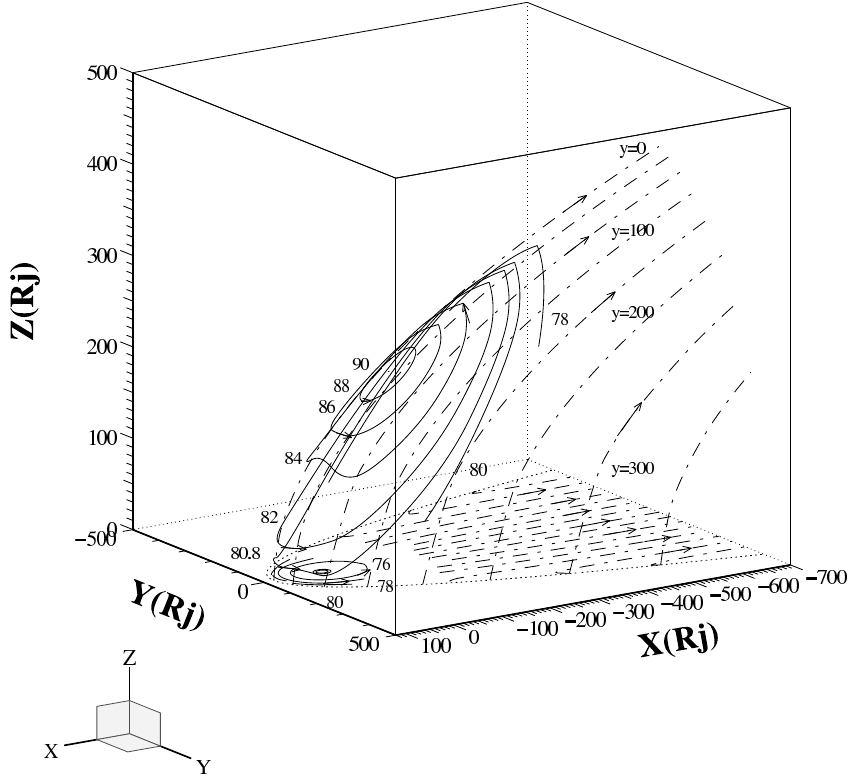
Fig. 2. Three-dimensional Jovian magnetosphere for northward IMF. Electric equipotentials of the corotation (solid curves) and solar wind (dashed-dotted curves) electric fields on the magnetopause and on the equatorial plane are shown. For the dashed-dotted curves, 1y = 50 R J and 1U = 0 . 75MV. For the solid curves on the equatorial plane (from the outer to inner) the latitudes and electric corotation potentials are: 80 ◦ , 0 . 4MV; 78 ◦ , 1 . 4MV; 76 ◦ , 4 . 3MV; 74 ◦ , 7 . 6MV; 0 ◦ , 356MV, respectively. For the solid curves on the magnetopause (from the outer to inner) the corresponding values are: 81 ◦ , 0MV; 82 ◦ , − 1 . 9MV; 84 ◦ , − 5 . 1MV; 86 ◦ , − 7 . 4MV; 88 ◦ , − 8 . 8MV; 90 ◦ , − 9 . 2MV, respectively. IMF and model parameters are as for Fig.